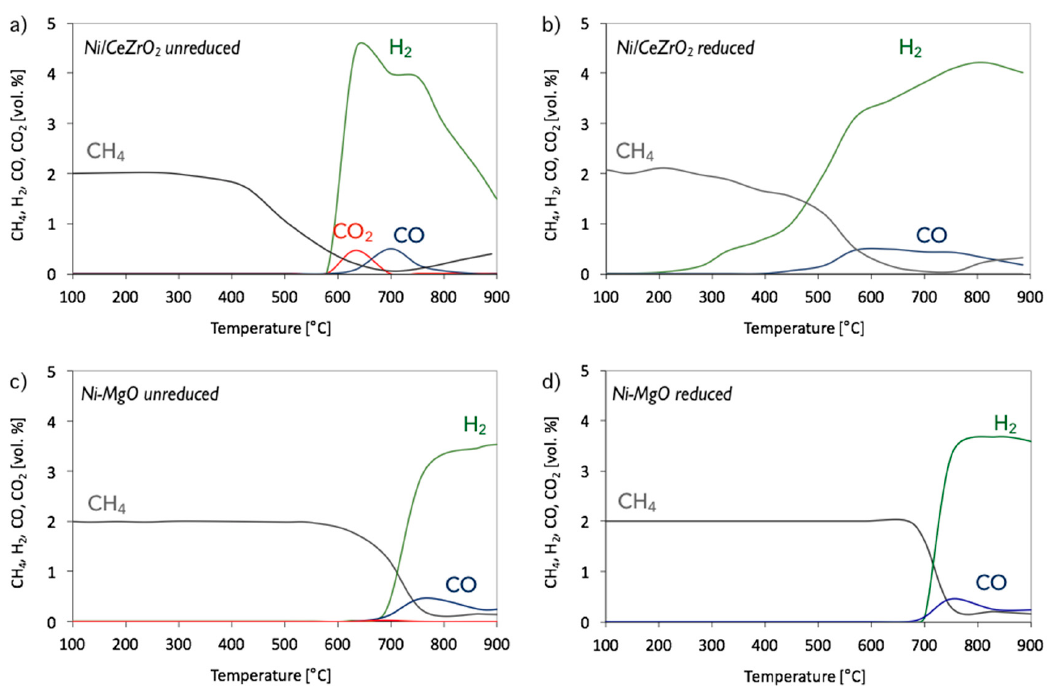
Figure 2. The composition of the outlet gas during CH 4 decomposition in temperature-programmed conditions over ( a ) unreduced Ni/CeZrO 2 , ( b ) pre-reduced Ni/CeZrO 2 , ( c ) unreduced Ni-MgO and ( d ) pre-reduced Ni-MgO. Test conditions: 2 vol.% CH 4 /Ar.